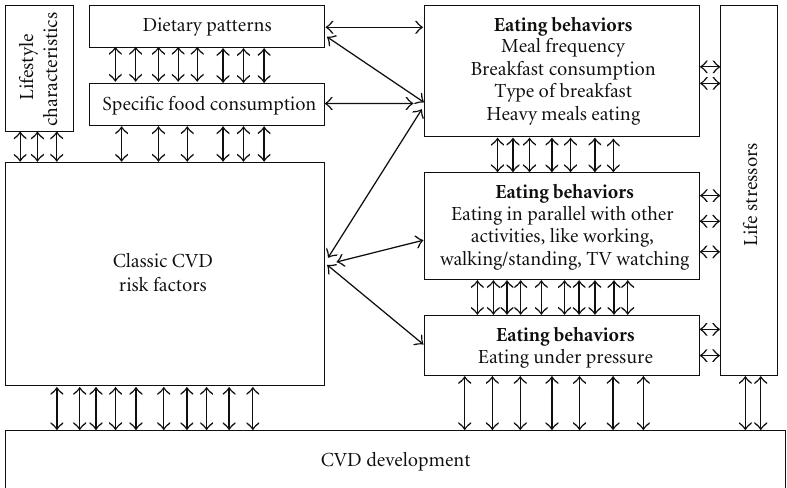
Figure 1: A conceptual model about dietary patterns, eating and lifestyle behaviours, and practices that will be tested in this study regarding the development of